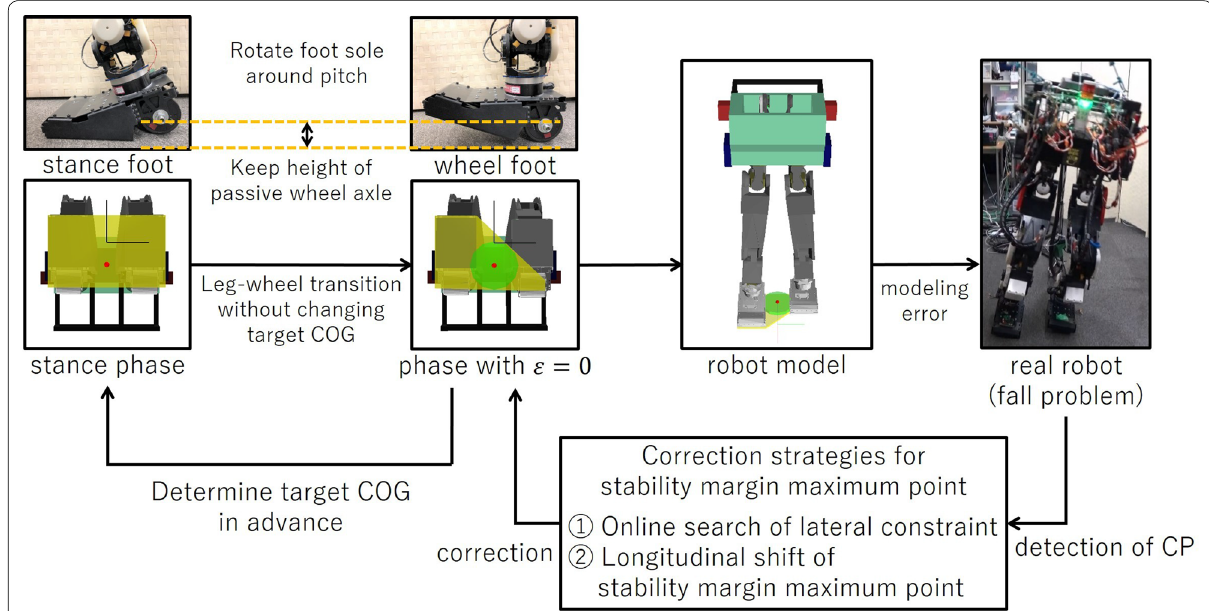
Fig. 11 Block diagram of leg-wheel transition and approach to solve fall problem of real